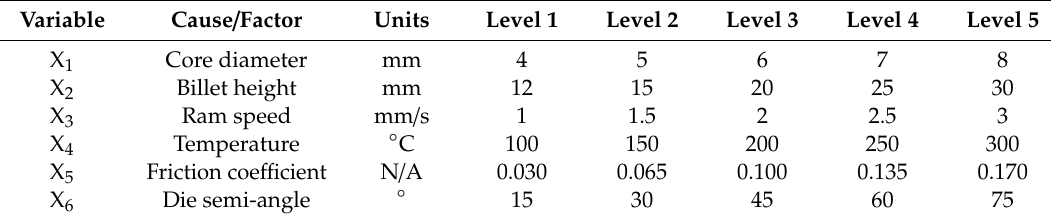
Table 5. Cause / parameter values distributed by